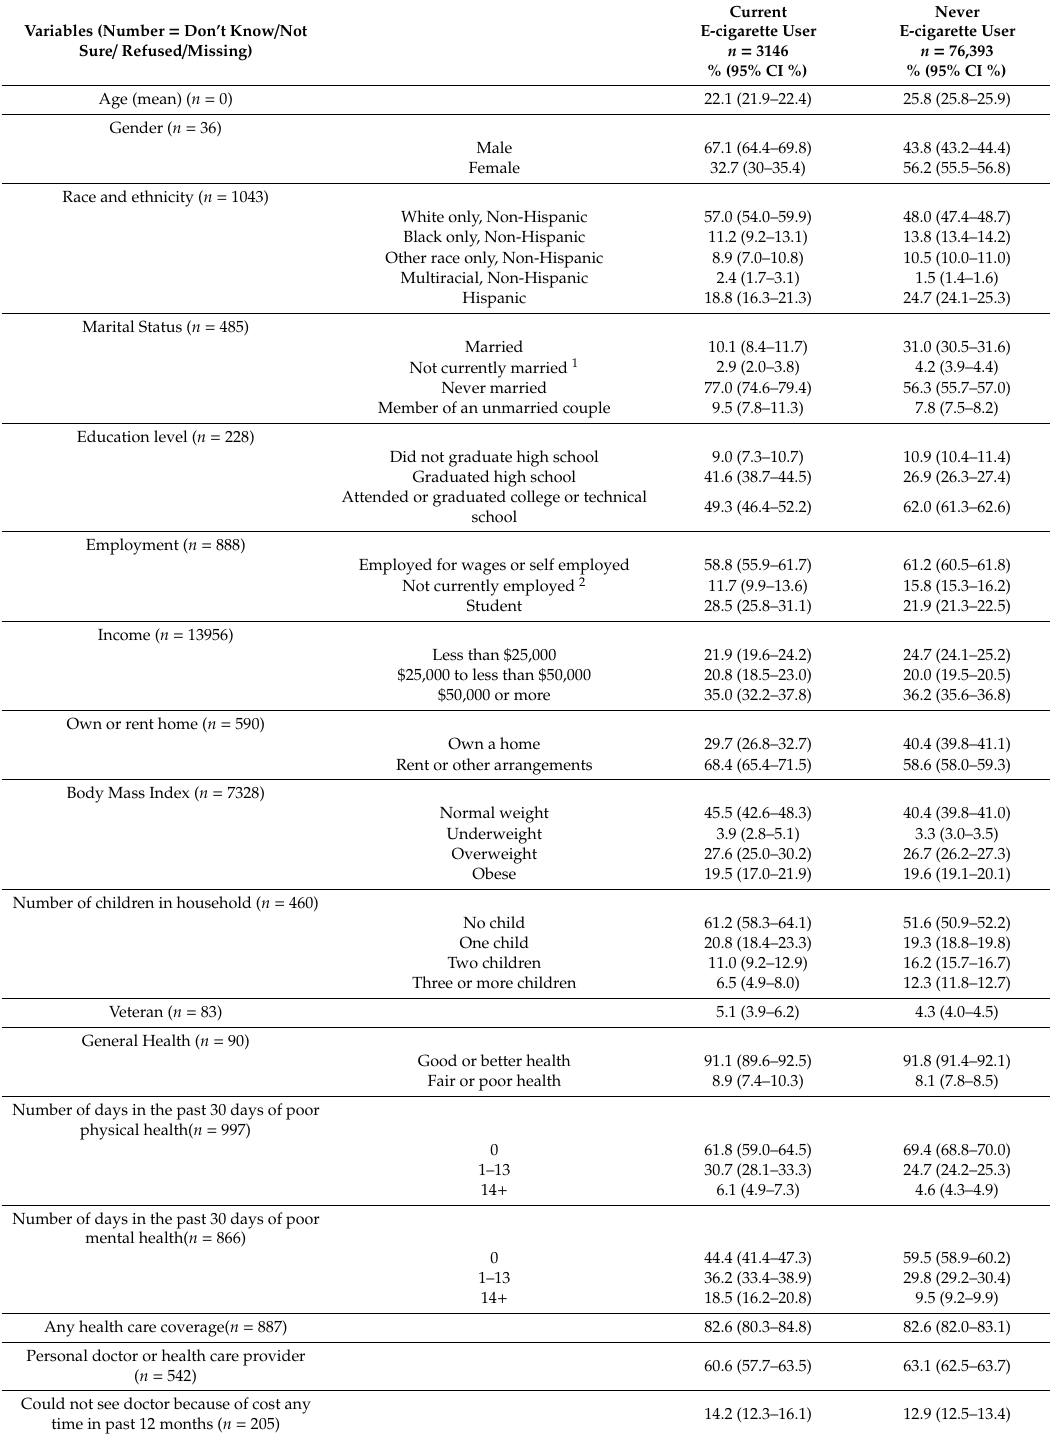
Table 1. Descriptive Statistics of the Variables Selected by Either Boruta or Least Absolute Shrinkage and Selection Operator (LASSO) for Young Adult Never Smokers Stratified by E-cigarette